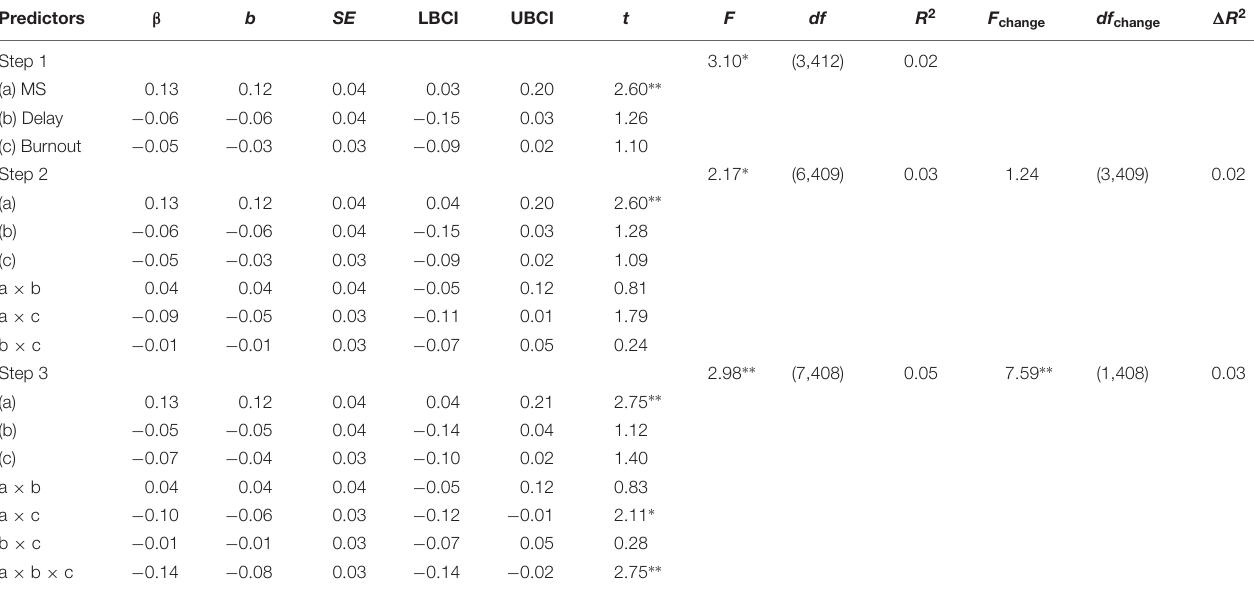
TABLE 3 | Hierarchical regression analysis, dependent variable: representation of the self as a valuable caregiver ( N = 416).